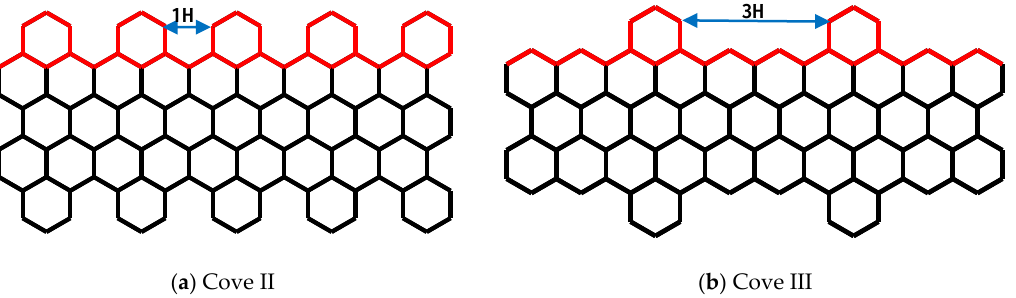
Figure 5. Schematic of CGNR corresponding to ( a ) 1H and ( b ) 3H.